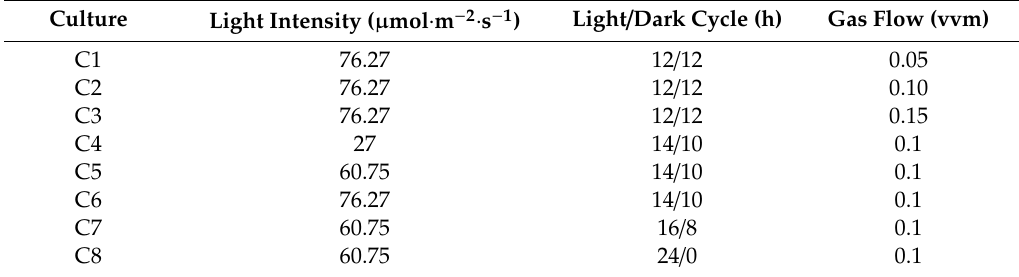
Table 1. Experimental conditions of the